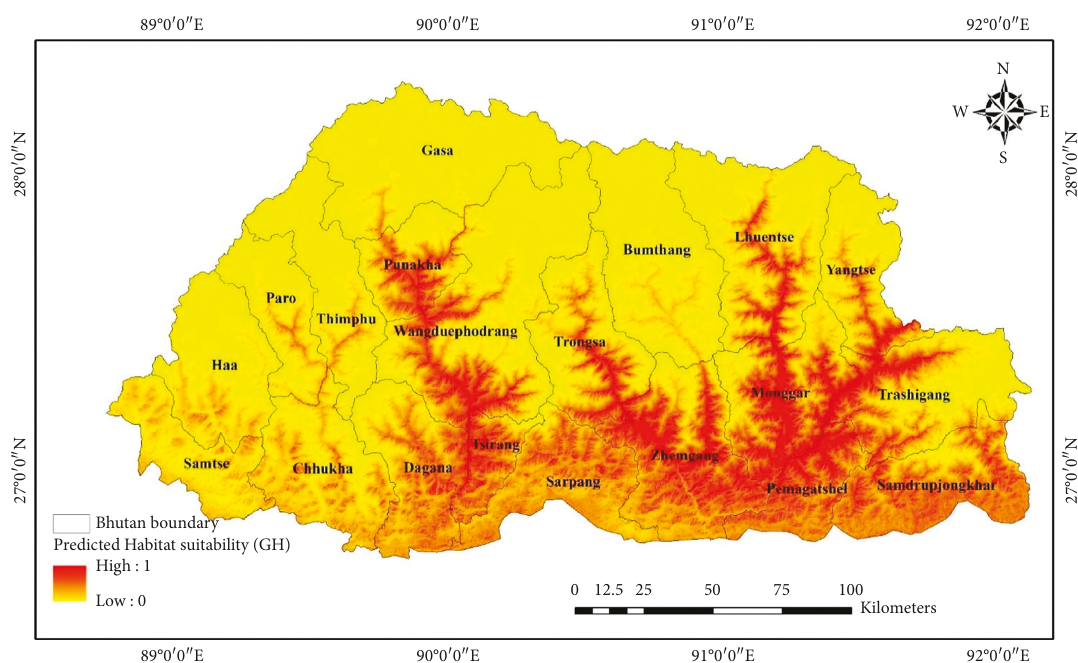
Figure 5: Predicted RNH occurrence map from low to high probability values.